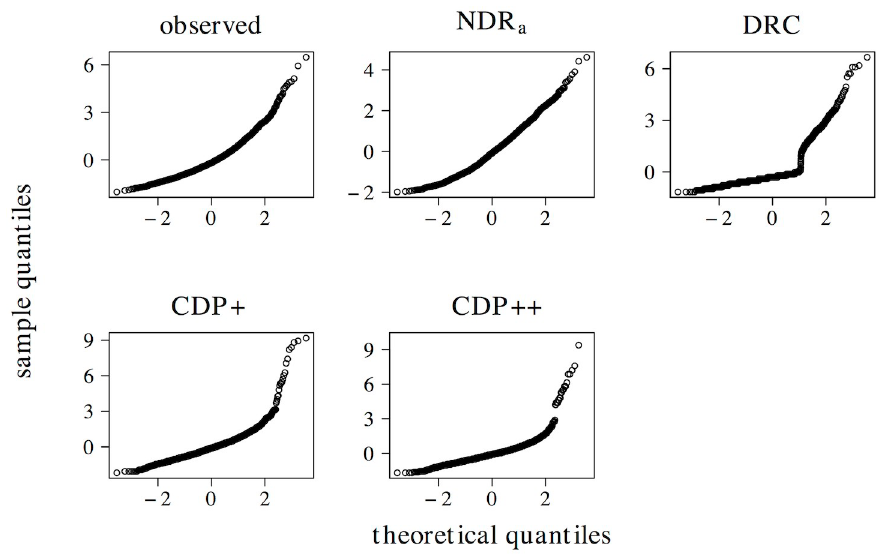
Fig 24. Naming latency distributions. Quantile-quantile plots of the observed naming latencies and the naming latencies simulated by the NDR and CDP + models. A